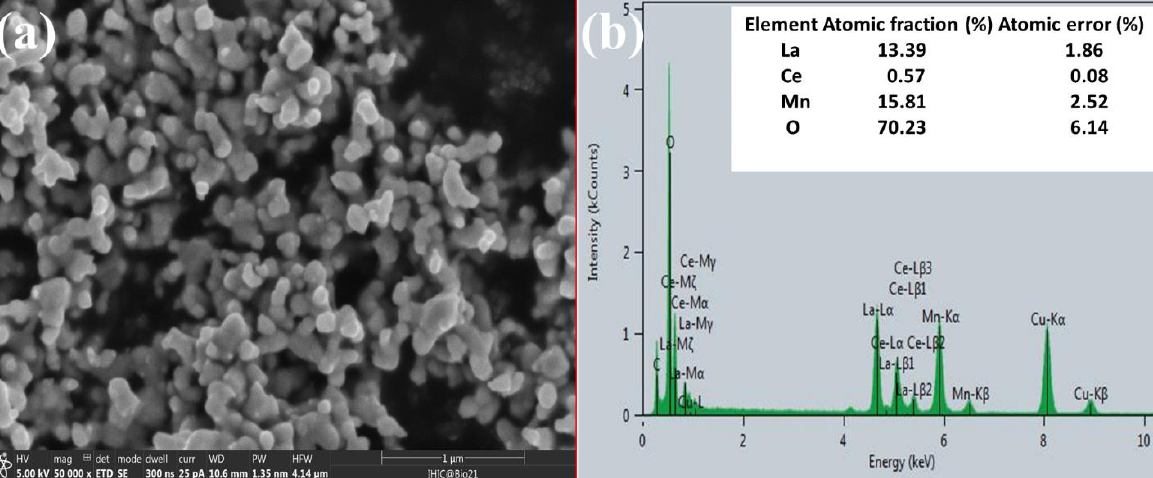
Figure 4. ( a ) FE-SEM image and ( b ) EDX analysis of as-prepared Ce 0.1 La 0.9 MnO 3 (CLMO) nanostruc- tures. The spectrum shows a peak in 8 KeV, which is attributed to ‘Copper’ appear ing from the supporting microscopic grid.